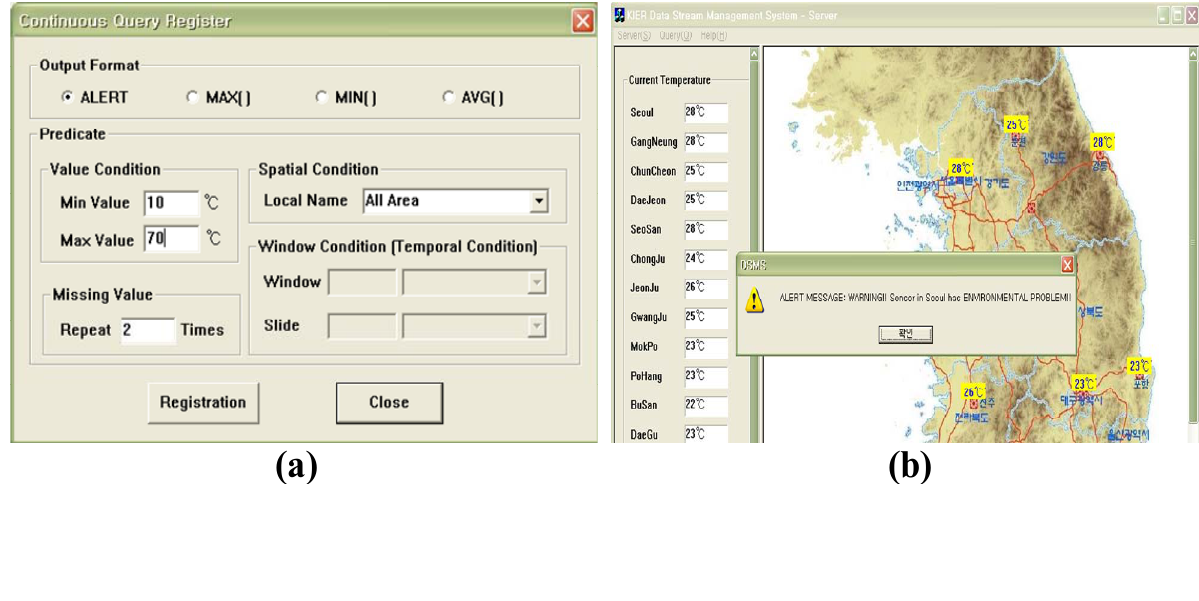
Figure 10. Continuous query registered to detect an environmental event in which ( a ) allows the registering of a query for anomaly detection; ( b ) displays the view of the detected event according to the registered